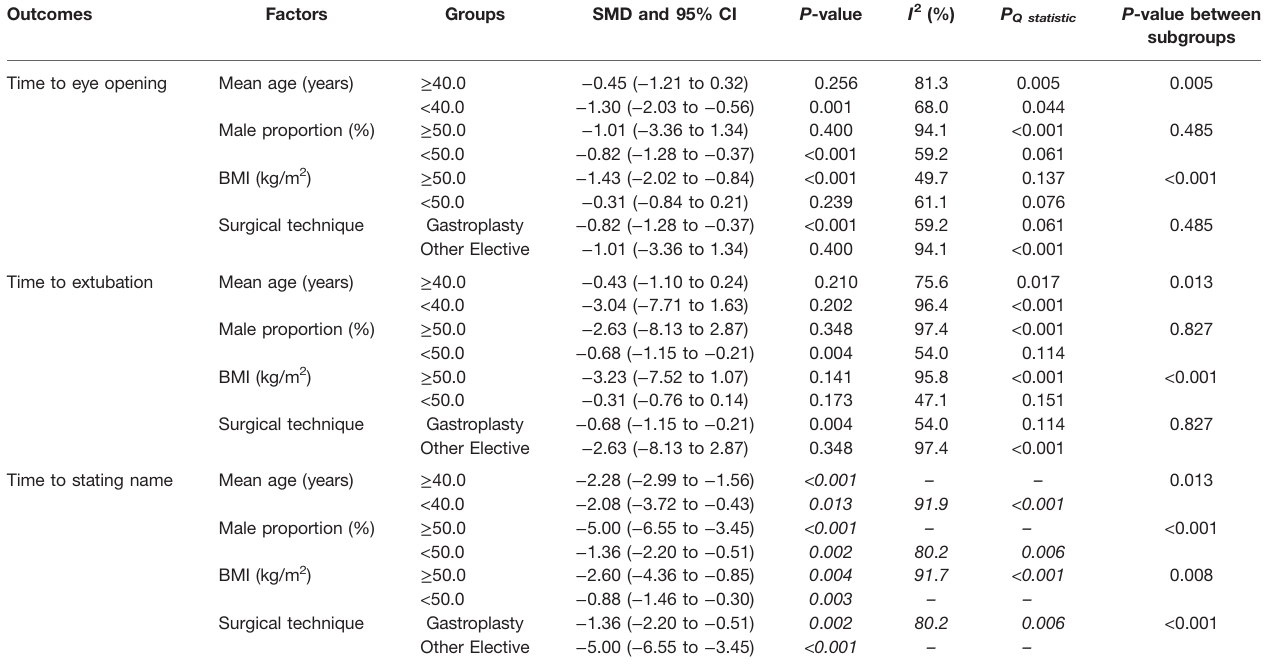
TABLE 2 | Subgroup analyses of des fl urane vs sevo fl urane for time to eye opening, time to extubation, and time to stating name. Outcomes Factors Groups SMD and 95% CI